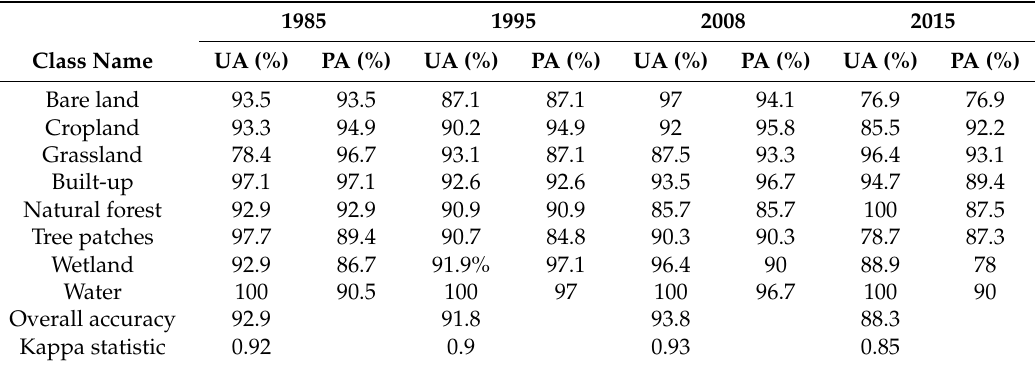
Table 5. Summary of the classification accuracies for 1985, 1995, 2008, and 2015. 1985 1995